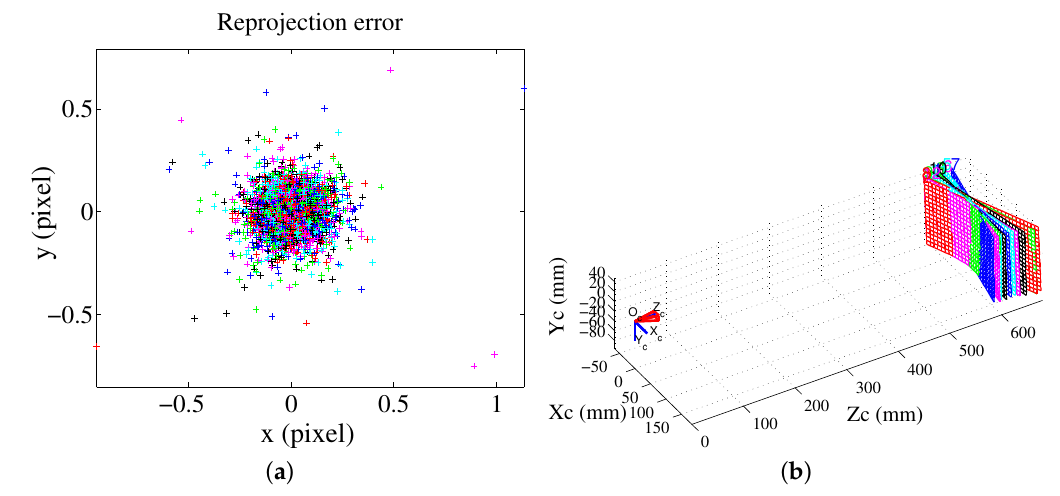
Figure 5. Camera calibration results. ( a ) Reprojection error and ( b ) relative positions of the calibration planes based on the camera coordinate